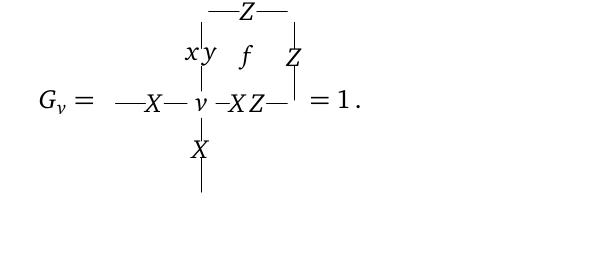
times X for those e ′ which intersect the framing of e e e ′ = Z = Z = Z X X X X X X , U , and U e 1 e 2 e 3 1 3 4 2 7 8 3 5 6